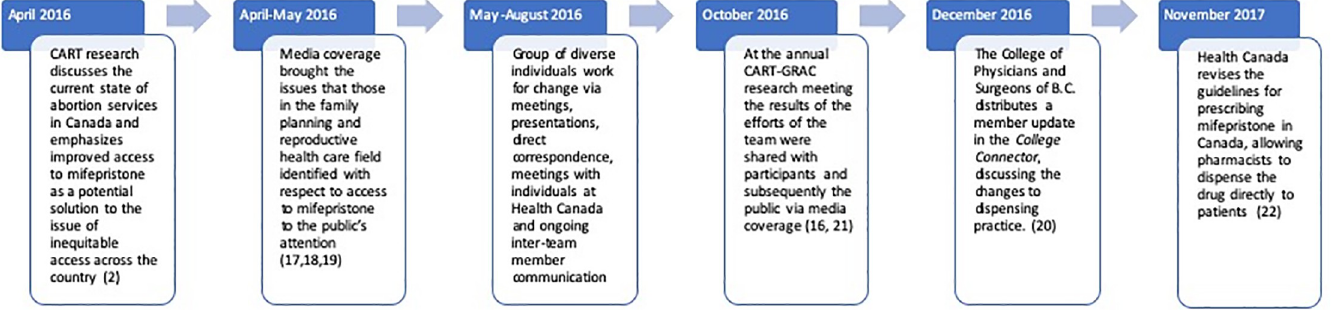
PLOS ONE | https://doi.org/10.1371/journal.pone.0227216 January 8,